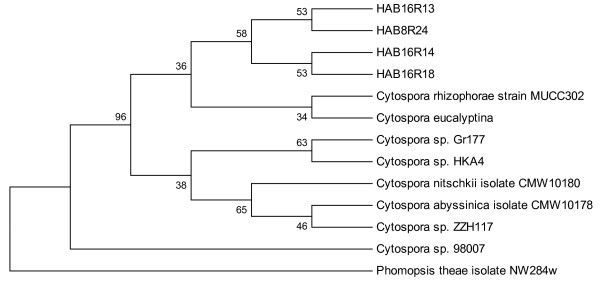
Tree obtained by heuristic search in phylogenetic analysis of the ITS regions of the rDNA of, HAB16R13, HAB16R14, HAB16R18 and HAB8R24 as well as reference isolates. Phomopsis theae isolate NW284w is used as outgroup. Bootstrap confidence level based on 1000 resamples is given on the appropriate branches.